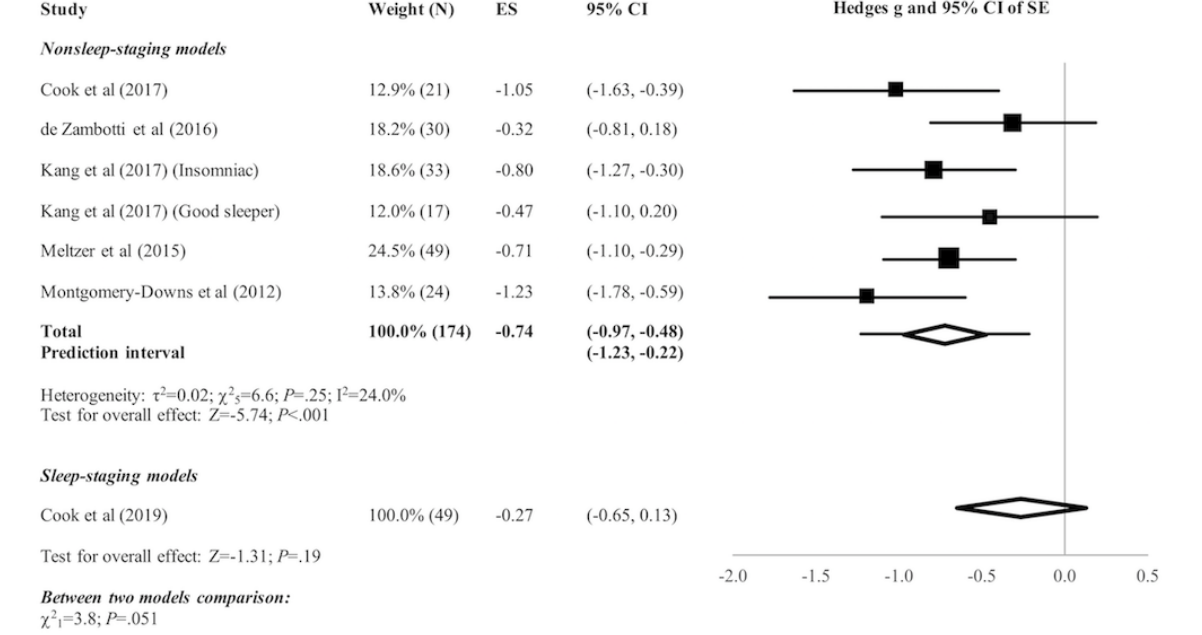
Figure 5. Forest plot of the standardized mean difference (Hedges g) between Fitbit and polysomnography for the variable of sleep efficiency (SE). Results are shown as effect size (ES) and 95% CI. The difference in symbol size indicates the difference in weight of the respective studies. The diamond symbol shows the 95% CI of the overall effect and the tails show the 95% prediction interval of the overall